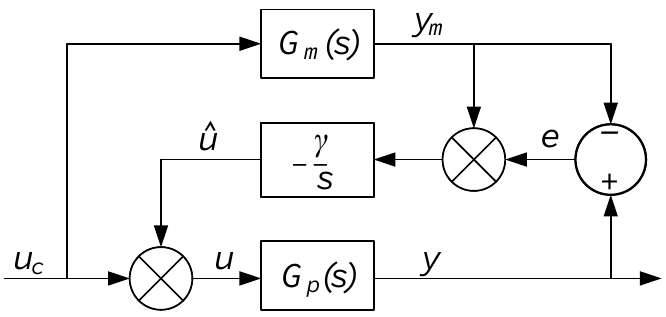
Figure 2. Model reference adaptive control based on